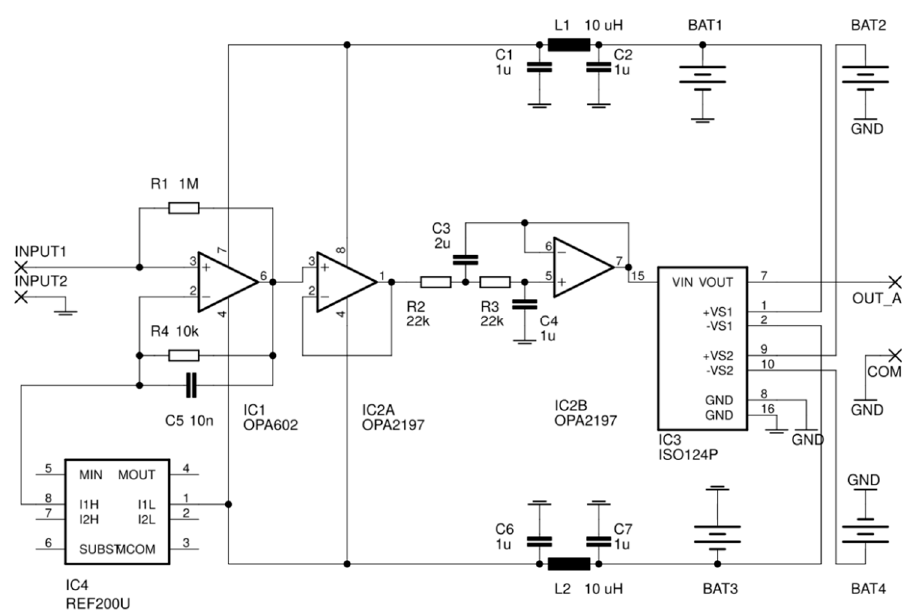
Figure 2. Schematic diagram of the circuit of prototype transducer device.